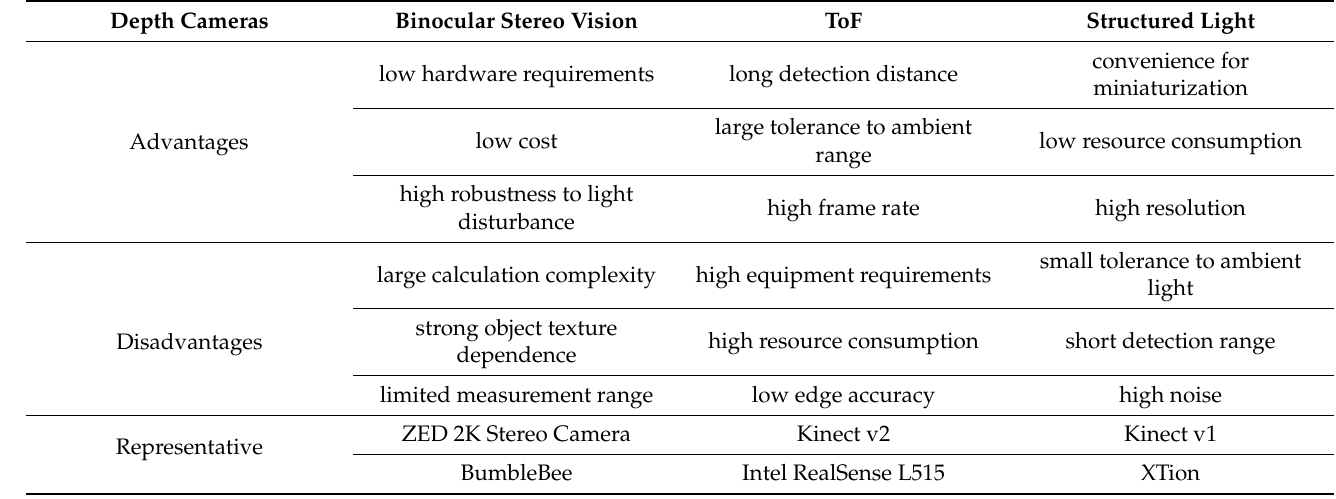
Table 1. Comparison of different depth